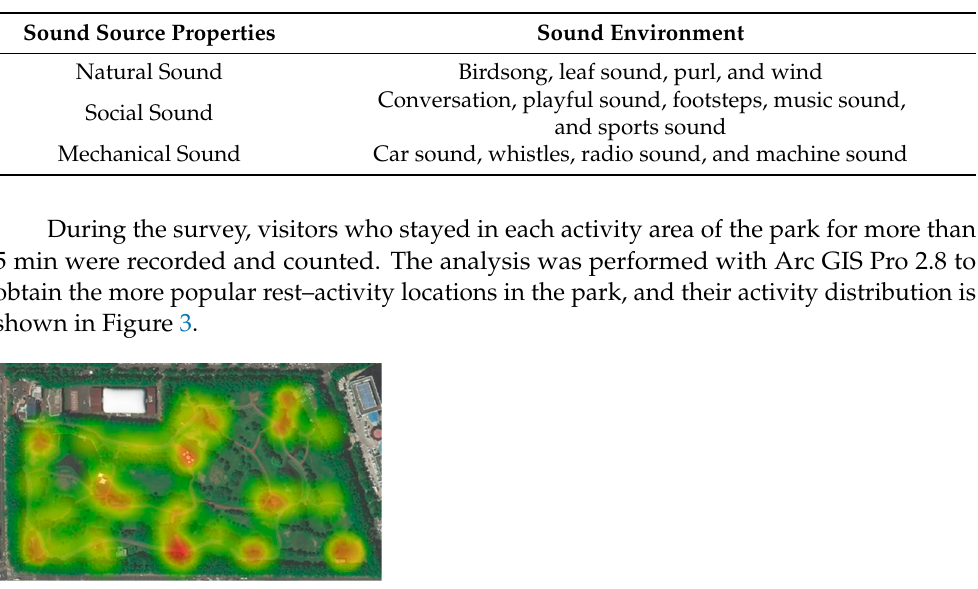
Table 2. Main types of acoustic environment in the park.